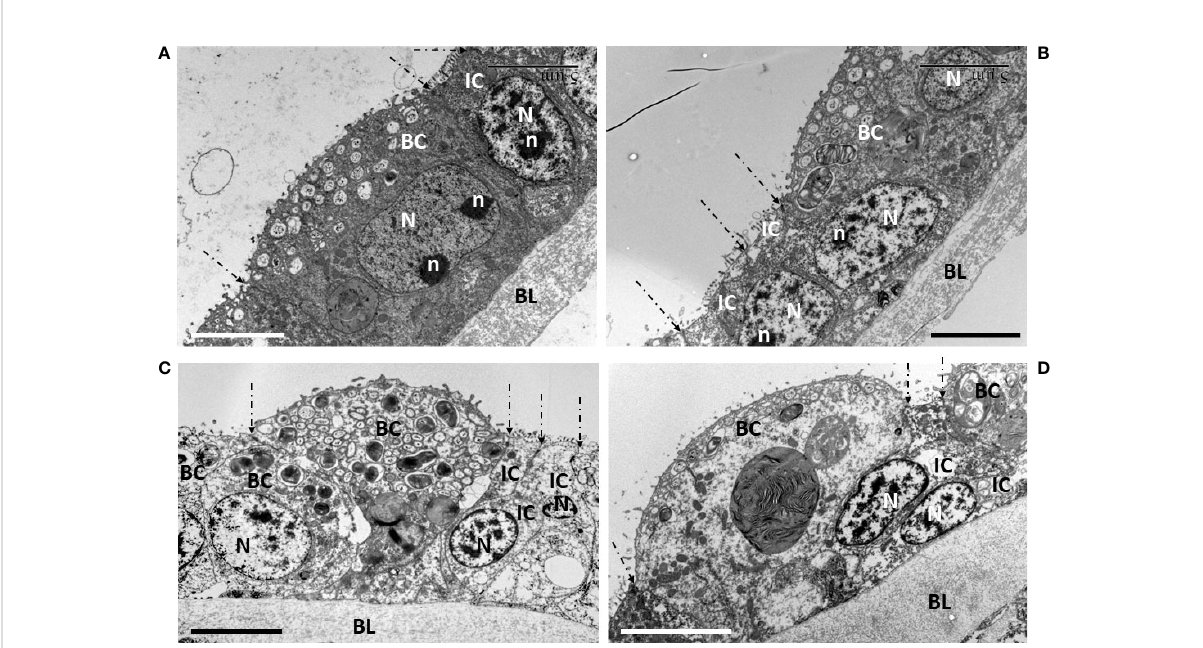
FIGURE 6 Signs of cell division during early starvation (d4, d7, d9). On all pictures, the limits between each cell are highlighted by dashed-lined arrows pointing to their apical tight-junctions. (A) a bacteriocyte at d7 that still contains symbionts and has no apical blebbing, shows an 8-shaped nucleus with two nucleolar masses, indicating the process of nuclear division was ongoing in this bacteriocyte. The neighboring intercalary cell and its nucleus occur in the same axis as this bacteriocyte, i.e. perpendicularly to the basal lamina. (B – D) focus on the narrow intercalary cells fl anking the bacteriocytes that are apically blebbing and more or less out-pocking above the apical surface of the gill fi lament. (B, D) the two narrow intercalary cells show their nuclei, very close to one another, suggesting they have recently divided. In addition, the more the bacteriocyte is out-pocking, the more the position of the nucleus in each intercalary cell bends obliquely towards the basal lamina, below the bacteriocyte. (B, D) (d7), (C) (d4). BC, bacteriocyte; BL, basal lamina; N, nucleus; n, nucleolus; IC, intercalary cell. Scale bars all represent 5